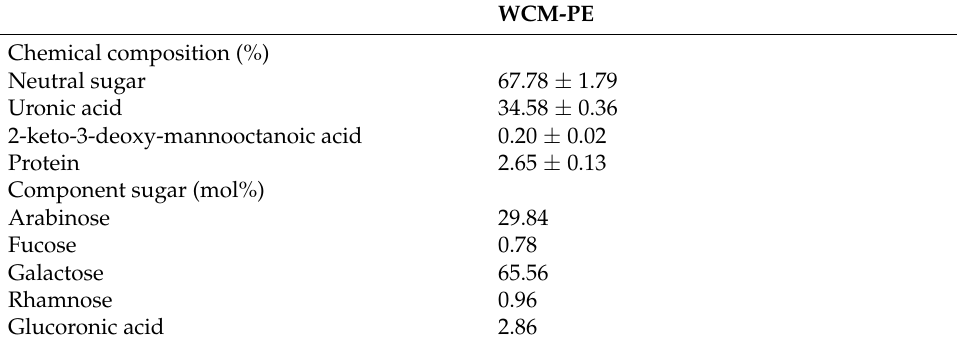
Figure 2. Phytochemical profile of the water extract of Commiphora myrrha resin (WCM) and its polysaccharides (WCM-PE). ( A ) Base peak and ultraviolet chromatogram of WCM. ( B ) Monosaccharide composition of WCM-PE. ( C ) High-performance size-exclusion chromatography refractive index (HPSEC-RI) chromatogram of WCM-PE. Fru, fructose; Man, mannose; Rib, ribose; Rha, rhamnose; Glc A, glucuronic acid; Gal A, galacturonic acid; Glc, glucose; Gal, galactose; Xyl, xylose; Arb, arabinose; Fuc, fucose. Table 1. Chemical composition of the polysaccharide fraction isolated from the water extract of Commiphora myrrha resin (WCM-PE).